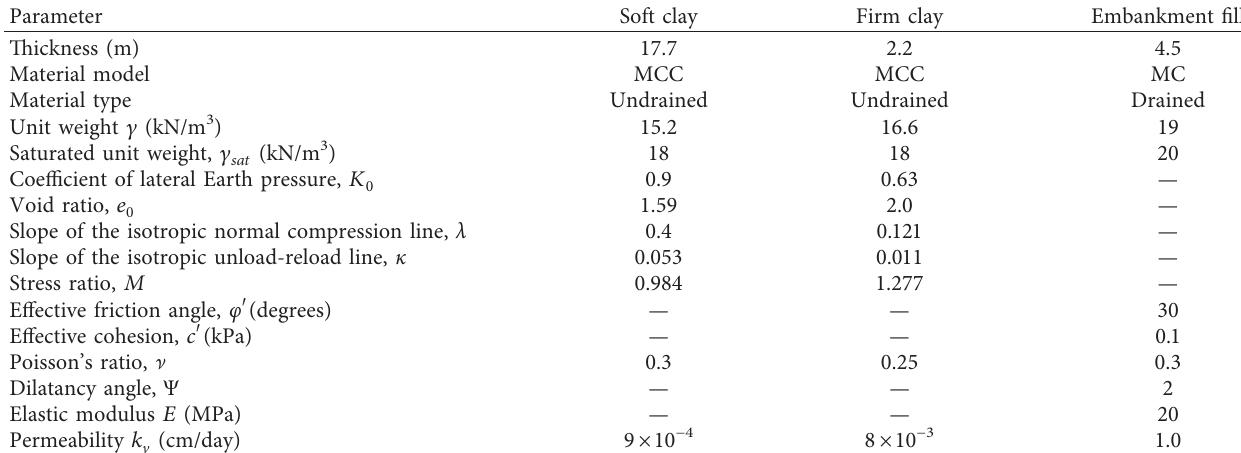
Table 1: Material properties of the embankment and